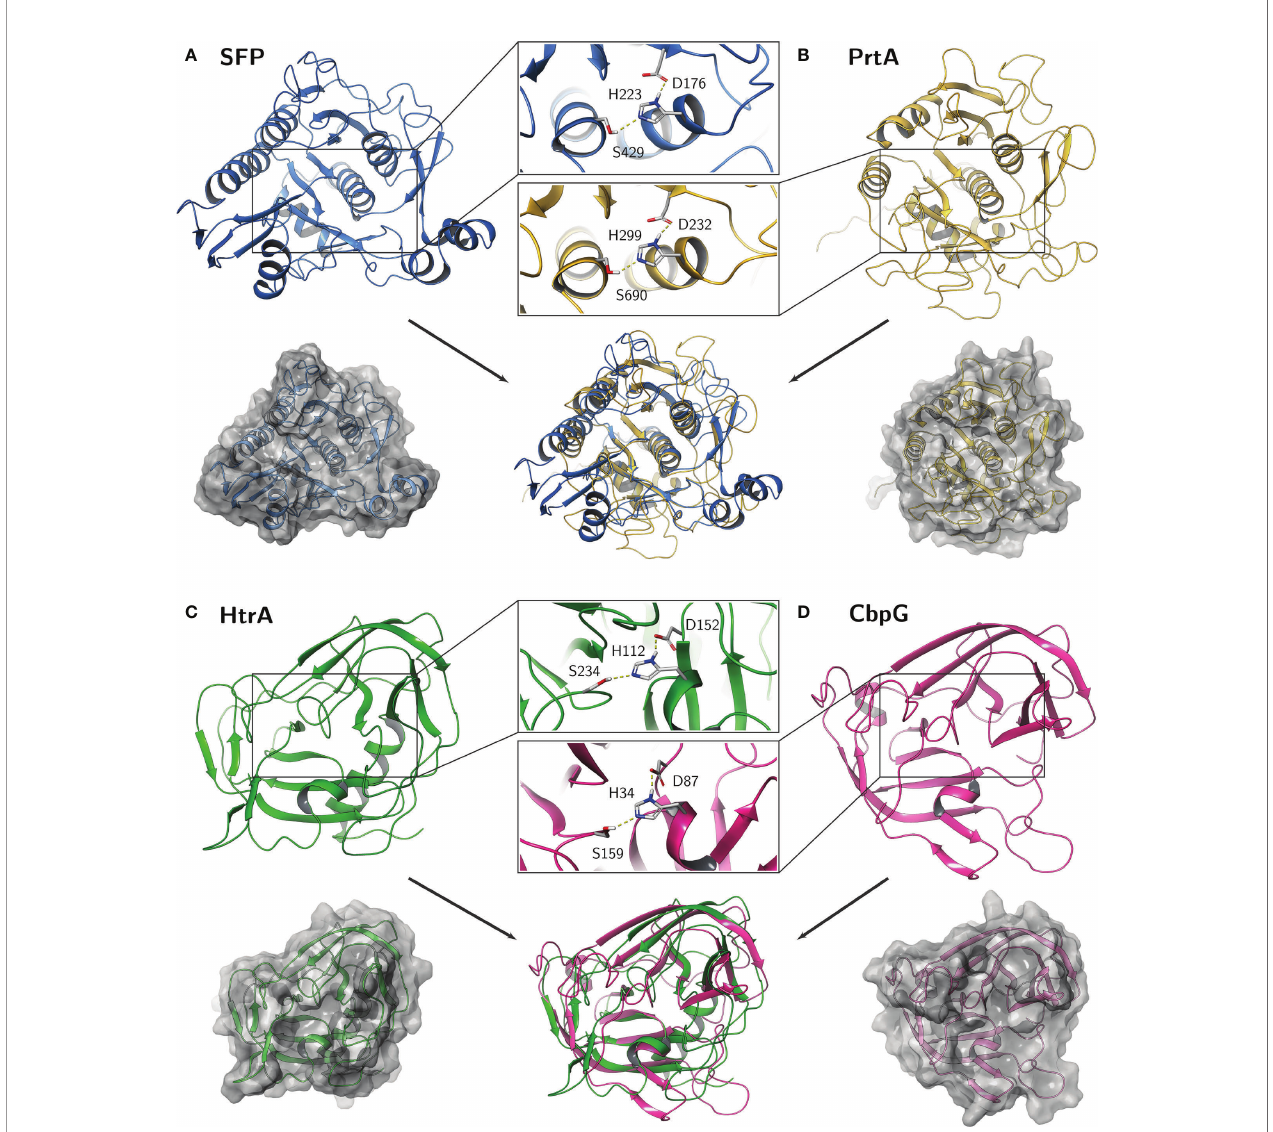
FIGURE 3 | Predicted homology models of the pneumococcal serine proteases. Catalytic residues aspartate (D), histidine (H), and serine (S) are shown as sticks in detail for (A) SFP, (B) PrtA, (C) HtrA, and (D) CbpG. The calculations were performed within the Multiple Sequence Viewer/Editor application in Maestro (Schrödinger,